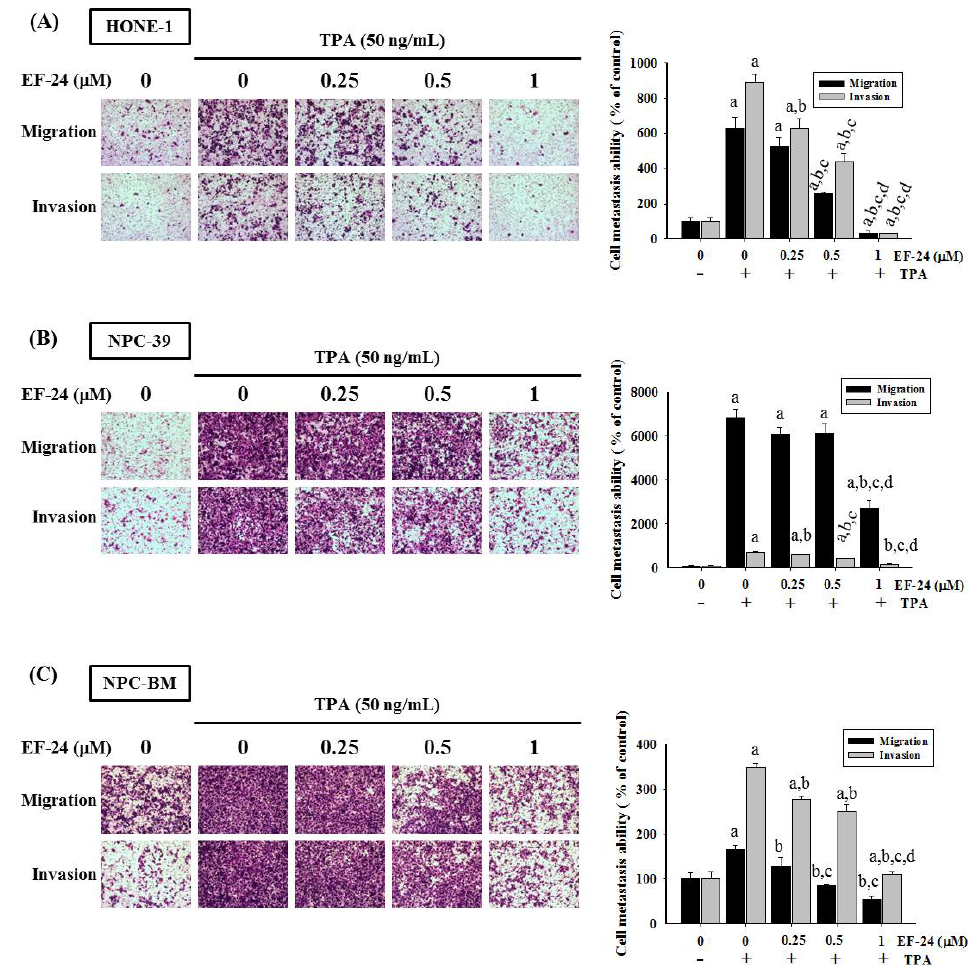
Figure 2. EF-24 impedes TPA-induced migrative and invasive responses in NPC cell lines. HONE-1 ( A ), NPC-39 ( B ), or NPC-BM cells ( C ) were incubated with various concentrations of EF-24 and TPA for 24 h. Cell migration and invasion were assessed in a Boyden chamber system coated without and with Matrigel, respectively. Quantification of responses is shown on the right. a Significantly different, p < 0.05, when compared with the control group. b Significantly different, p < 0.05, when compared with the TPA treatment group. c Significantly different, p < 0.05, when compared with the TPA treatment plus EF-24 (0.25 μM) group. d Significantly different, p < 0.05, when compared with the TPA treatment plus EF-24 (0.5 μM) group.